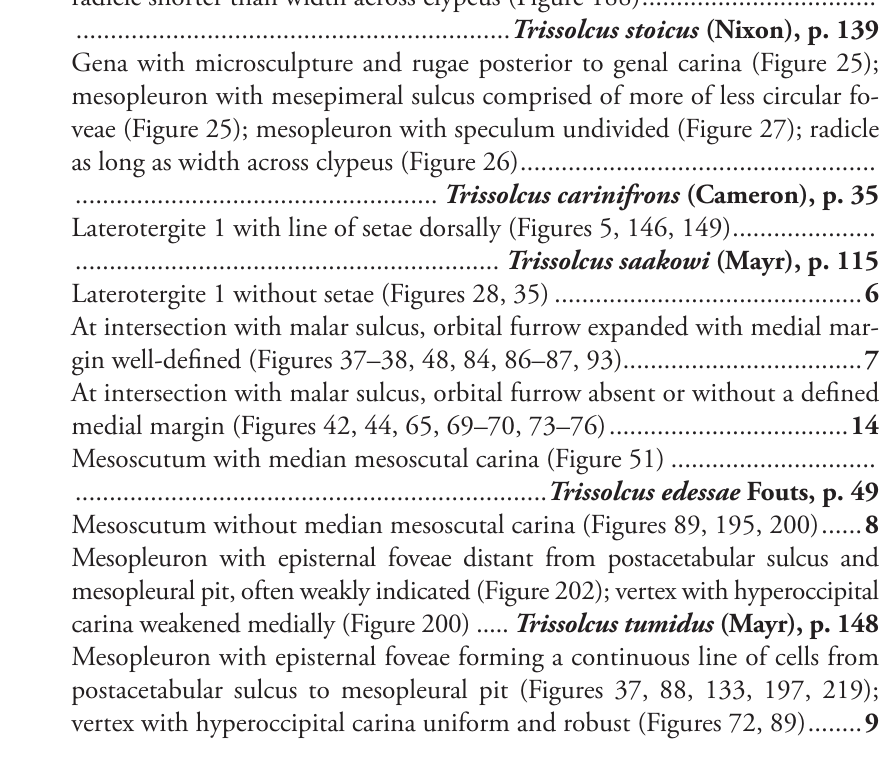
Key to Trissolcus of the Palearctic region (females) 1 Inner margin of eye with orbital furrow broad and transversely rugulose at midpoint of eye (Figure 61); clypeus with 2 setae (Figures 69–70) ................ – Inner margin of eye with orbital furrow smooth (Figure 48), narrow (Figures 54, 97), or poorly defined at midpoint of eye; clypeus with 2–8 setae ......... 2 2 Vertex between lateral ocelli with hyperoccipital carina (Figures 24, 43, 72), carina sometimes weakened medially (Figures 47, 200, 206–207) ............... 3 – Vertex between lateral ocelli without hyperoccipital carina (Figures 29, 104, 108) .......................................................................................................... 18 3 Clypeus with 6 setae (Figure 26); mesopleural carina complete, extending to ventral mesopleural carina (Figure 25); mesoscutum with notauli weakly developed or absent (Figures 24, 184) ......................................................... 4 – Clypeus with 4 or fewer setae (Figures 39, 66); mesopleural carina variable; mes- oscutum often with distinct notauli (Figures 63, 68, 89) ......... 5 ( flavipes group) 4 Gena smooth and shining posterior to genal carina (Figure 185); mesopleuron with mesepimeral sulcus comprised of transversely elongate cells (Figure 185); mesopleuron with speculum divided by dorsoventral furrow (Figure 185); radicle shorter than width across clypeus (Figure 188) .................................. ............................................................... Trissolcus stoicus (Nixon), p. 139 – Gena with microsculpture and rugae posterior to genal carina (Figure 25); mesopleuron with mesepimeral sulcus comprised of more of less circular fo- veae (Figure 25); mesopleuron with speculum undivided (Figure 27); radicle as long as width across clypeus (Figure 26) .................................................... Laterotergite 1 with line of setae dorsally (Figures 5, 146, 149) .....................